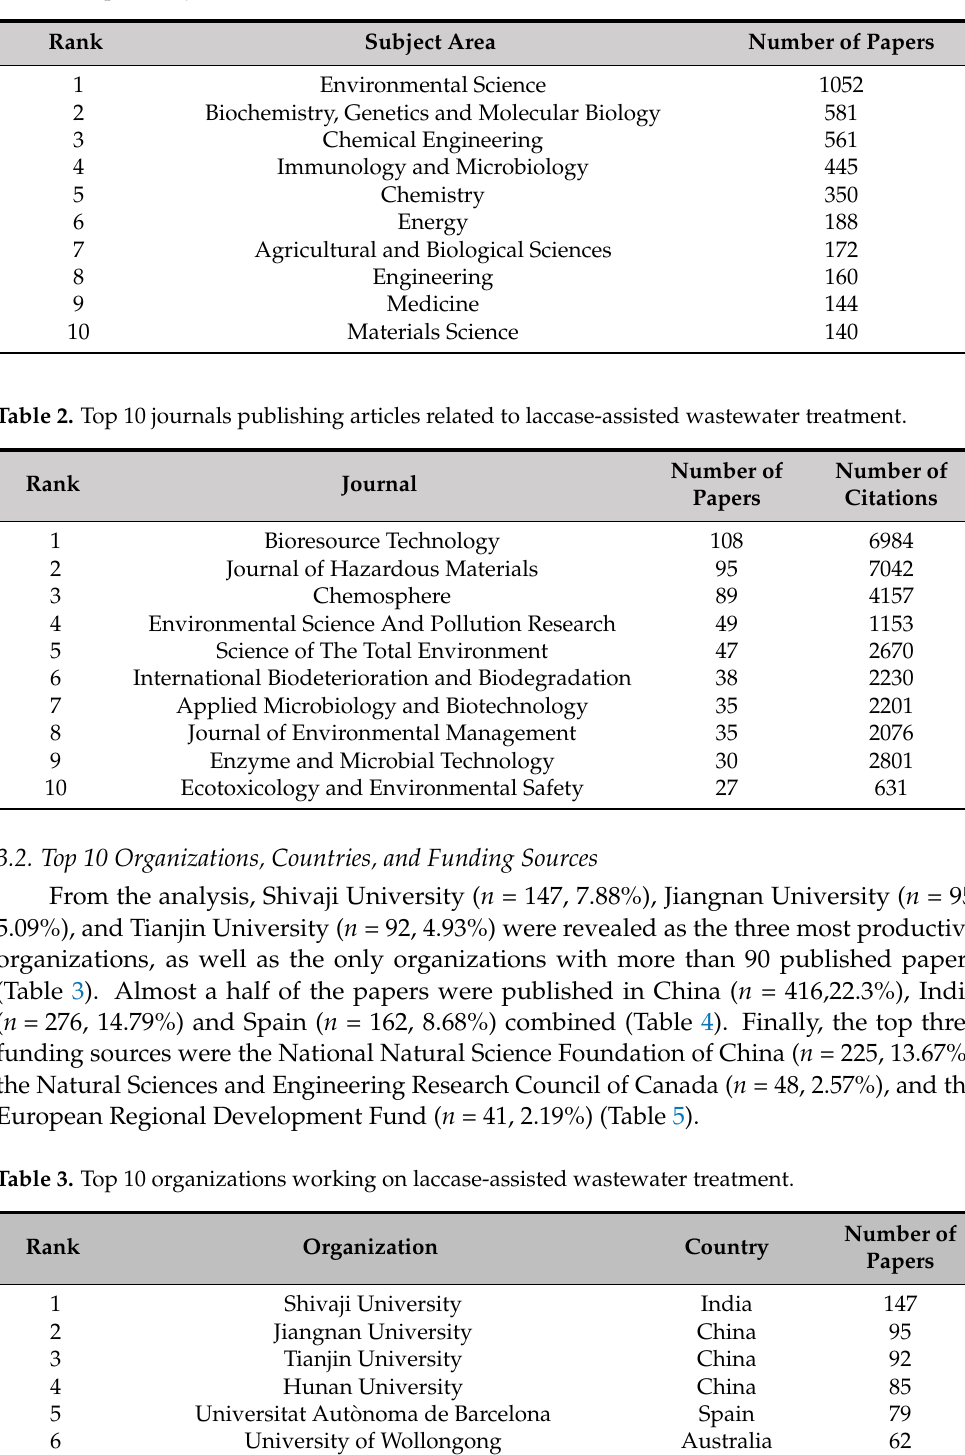
Table 1. Top 10 subject areas related to laccase-assisted wastewater treatment studies.